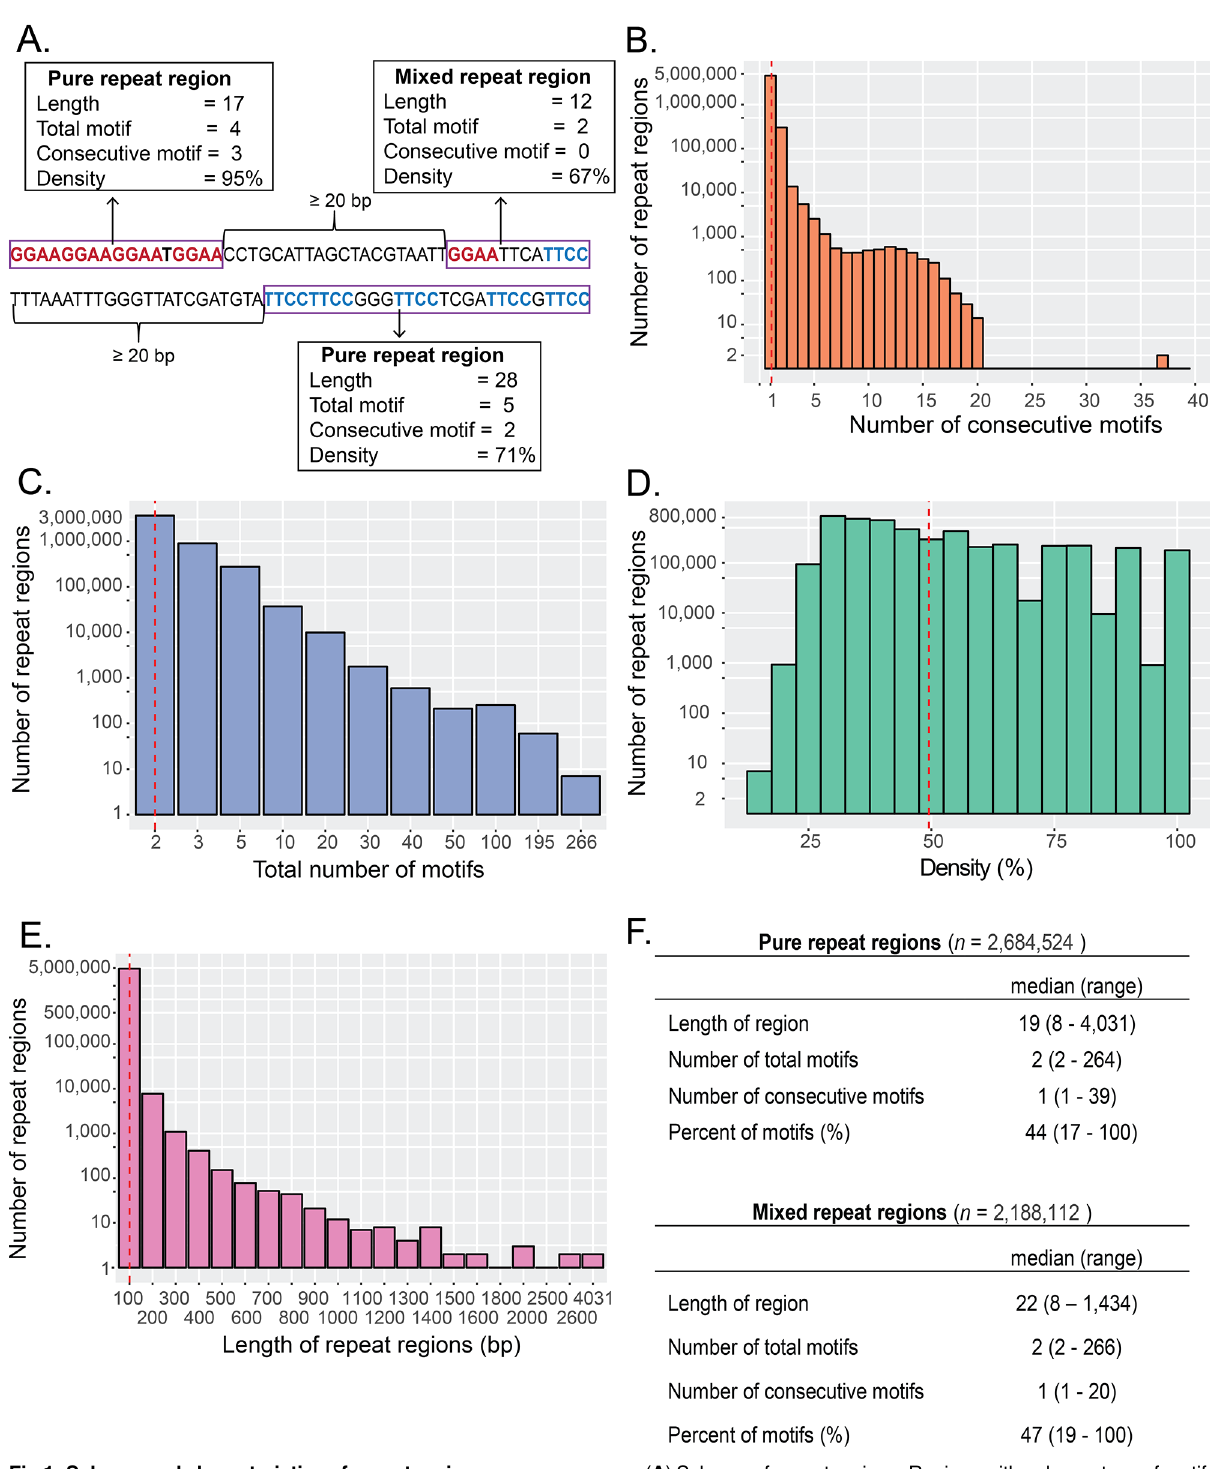
Fig 1. Schema and characteristics of repeat regions across genome. ( A ) Schema of repeat regions. Regionswith only one type of motif are called pure repeat regionwhile those with both GGAA and TTCC are called mixed repeat regions. Each repeat region(purplebox) is separatedby at least 20-bp consecutive non-motifs. ( B ) Histogram of maximum number of consecutive motifs. ( C ) Histogram of total number (cid:16) (cid:17) (cid:2) 100% . Bin width is 5%. ( E ) Histogramof length of of motifs. ( D ) Histogram of motif density of repeat regions. Density ¼ total number of motifs (cid:2) 4 length of regions repeat regions. Each bin is 100bp width (e.g., first bin is 0-100bplength). Bins with zero repeat regionsare not shown. ( F ) The characteristics of repeat regions for pure and mixed repeat regionsacross the genome. Red line indicatesthe mean for each characteristic. https://doi.org/10.1371/journal.pone.0186275.g001 PLOS ONE | https://doi.org/10.1371/journal.pone.0186275 November1,